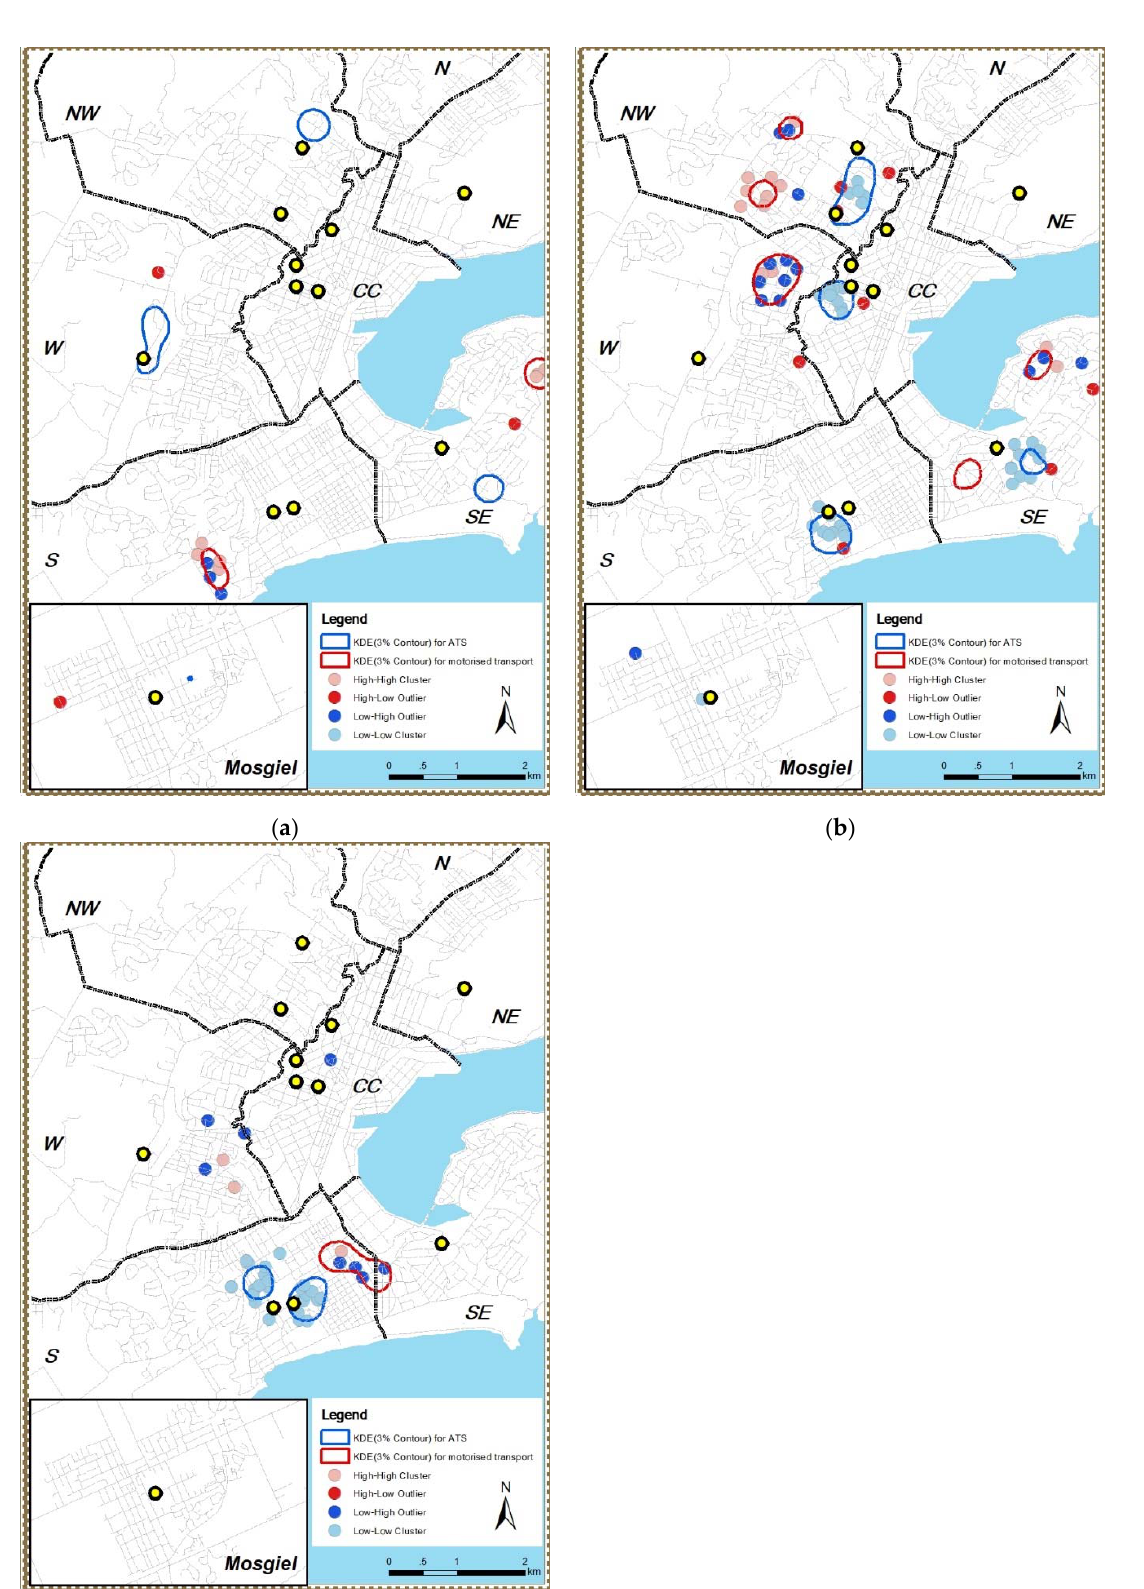
Figure 5. KDE and LISA transport modes distribution on intersection density: ( a ) low home neighbourhood intersection density; ( b ) medium home neighbourhood intersection density; ( c ) high home neighbourhood intersection density.